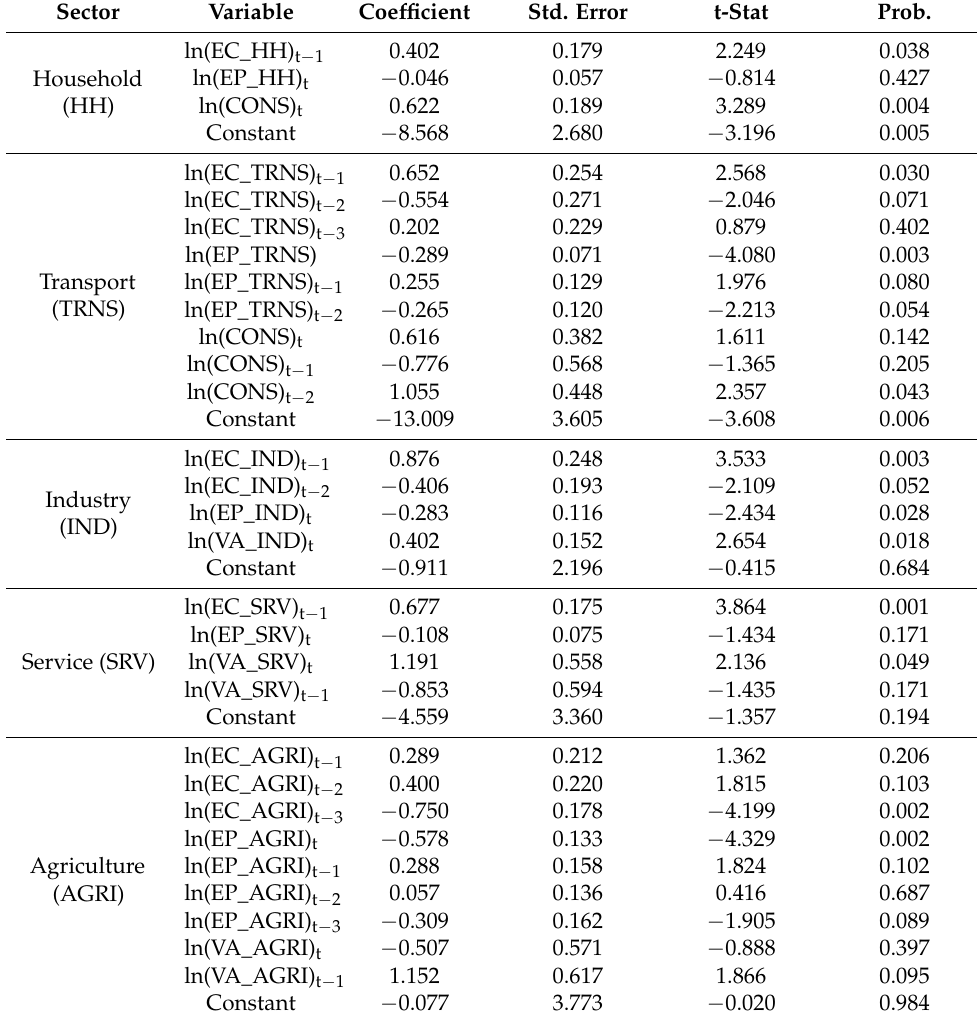
Table A2. Short-term results for econometric analysis of